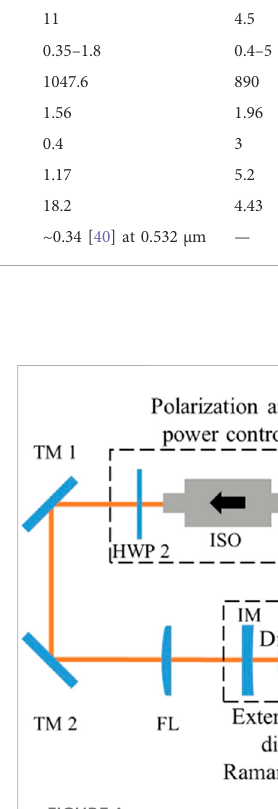
FIGURE 1 The experimental setup in [25]. HWP, half-wave plate; ISO, optical isolator; TM,turning mirror; FL,focus lens;IM, input mirror; OC,outputcoupler;LF,long-pass fi lter.Imageoriginallypublished in Ref. [25] and reproduced with permission from IOP